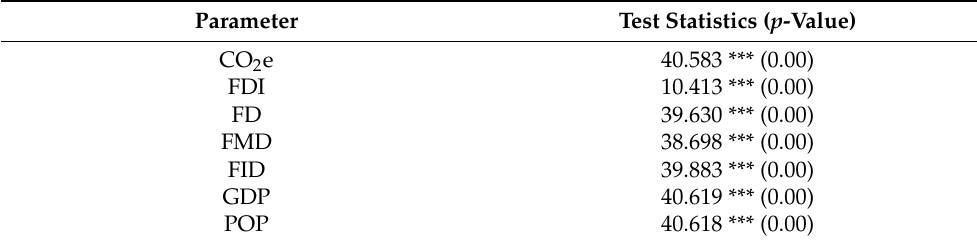
Table 3. Results achieved for CSD analysis.